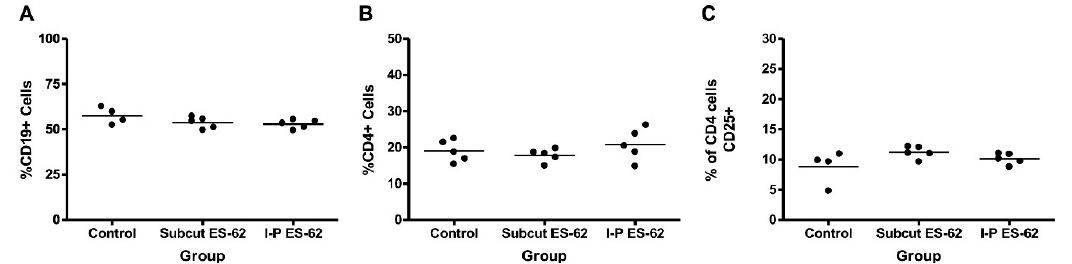
Figure 2. Effects of ES ‐ 62 on in vitro cytokine secretion by dendritic cells (DCs). DCs were prepared from bone marrow as described in the Materials and Methods. On day 10, they were harvested and incubated with medium alone, 500 ng/mL of LPS, 2 μ g of ES ‐ 62 or with both 500 ng/mL of LPS and 2 μ g of ES ‐ 62. At 72 h, supernatants were harvested and assayed for the presence of ( A ) IL ‐ 12p40, ( B )